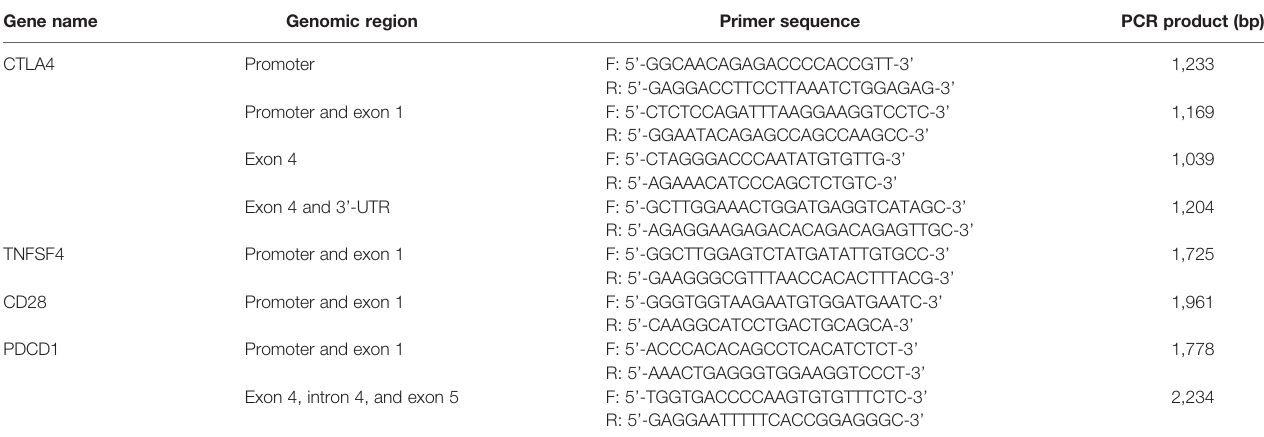
TABLE 2 | Primer sequences used for PCR and DNA